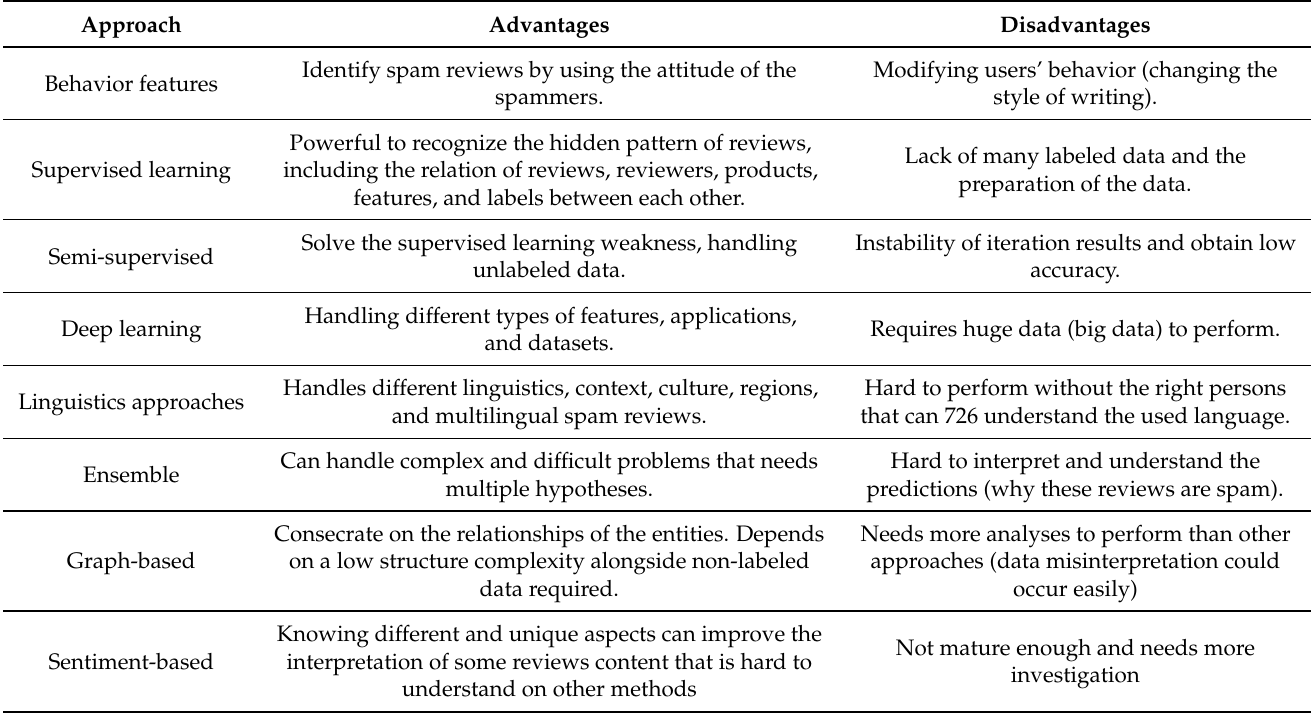
Table 2. Advantages and disadvantages of the reviewed approaches.